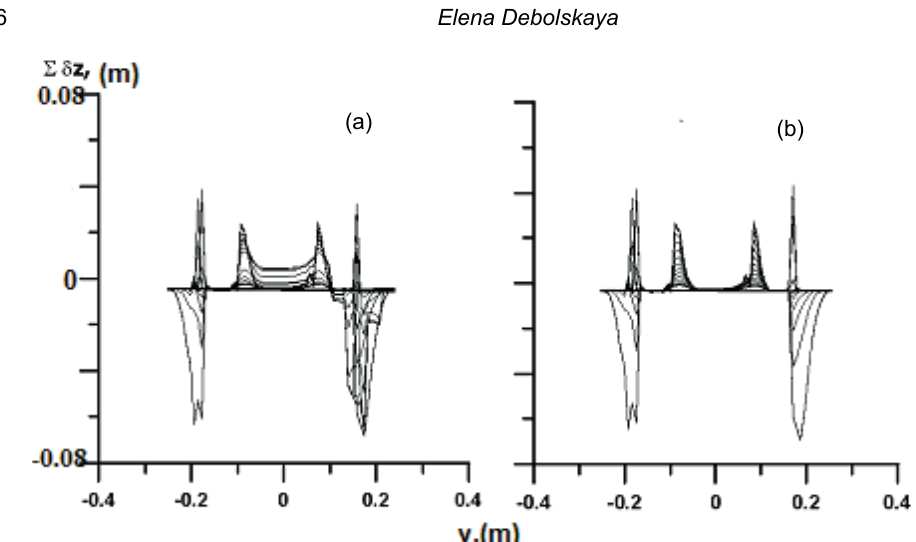
Fig. 4 The positions of the bottom surfaces summed for all sections and time for the case of the presence of ice plates (a) in coastal slope and without them (b).